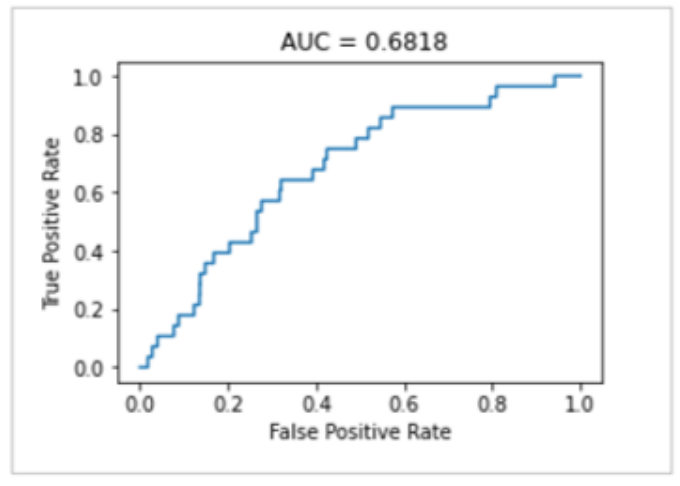
Figure 6. AUC and ROC curve of the Book